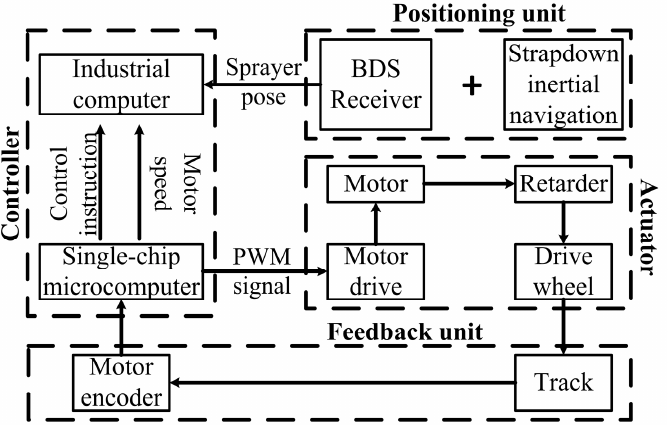
Figure 1. The design of the automatic navigation system of the spraying robot. According to the technical parameters of orchard spraying, a dual-motor independent drive crawler chassis was designed with a crawler center distance of 0.62 m and a crawler length of 2.2 m. Figure 2 shows the industrial computer, BDS positioning antenna and receiver (F-V111, Qianxun Weizhi Internet Inc., Shanghai, China), IMU (100D2, Beijing Sanchi Inertial Technology Co., Ltd., Beijing, China), servo motor, motor driver (KYDBL4875-2E, Jinan Keya Electron and Technology Inc., Jinan, China), single chip microcomputer development board, and encoder installed on the spraying robot. The positioning accuracy of the FV-111 BDS receiver reaches the centimeter level, with both horizontal and vertical static positioning errors below 1.5 cm. The 100D2 has a built-in three-axis accelerometer, a three-axis gyroscope, and a three-axis magnetometer, of which the three-axis accelerometer has a measurement √ range of ± 2 g, the zero bias of 5 mg, and the noise density of 110 µ g/ Hz; the three-axis gyroscope has a measurement range of ± 1000 ◦ /s, the zero bias of 50 ◦ /h, and the noise √ density of 0.005 ◦ /s/ Hz. The system obtains the position and attitude information through the combination of the BDS receiver and IMU, and the industrial computer is utilized as the control terminal of the spraying robot for information acquisition and decision calculation, which was transmitted to the single chip microcomputer. The single chip